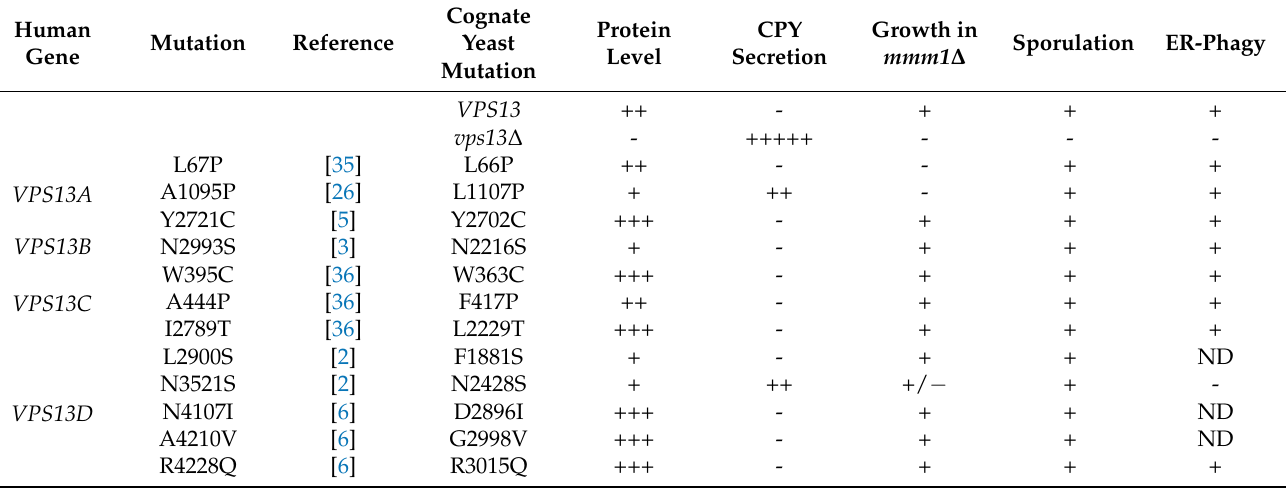
Table 1. Characterization of VPS13 family disease alleles in yeast.